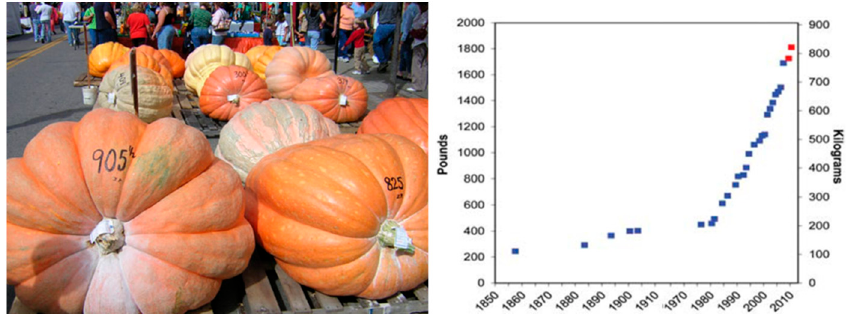
Figure 6. Right , fruits of Show cultivar-group at Barnesville Pumpkin Festival in Barnesville, Ohio, USA, picture credit Lee Paxton (https://en.wikipedia.org/wiki/User:Leepaxton, accessed on 15 June 2021). Left , world records of pumpkin fruit weight [65].